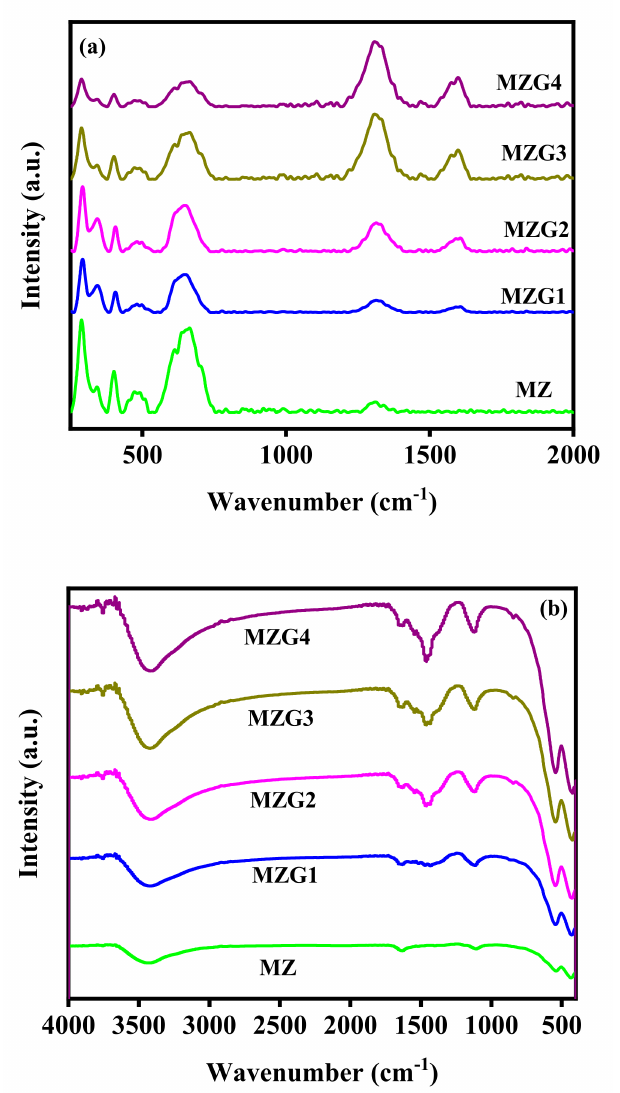
Figure 2. Raman ( a ) and FTIR ( b ) spectra of MZ, MZG1, MZG2, MZG3, and MZG4 crystalline